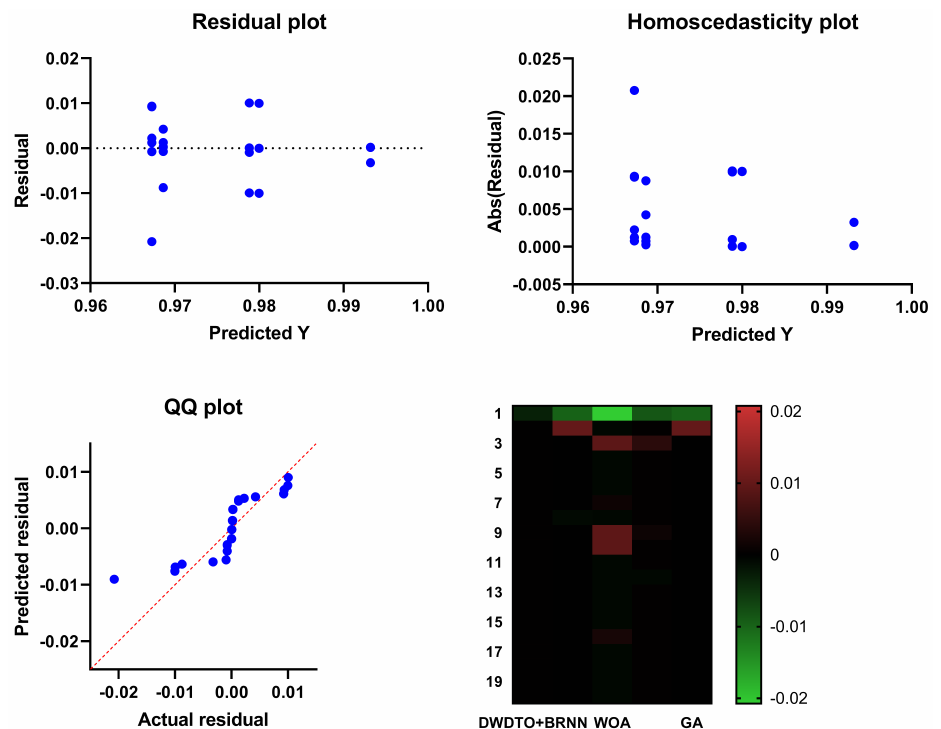
Figure 9. Visual representation of the results achieved by the proposed optimization algorithm in terms of the second dataset (D2).